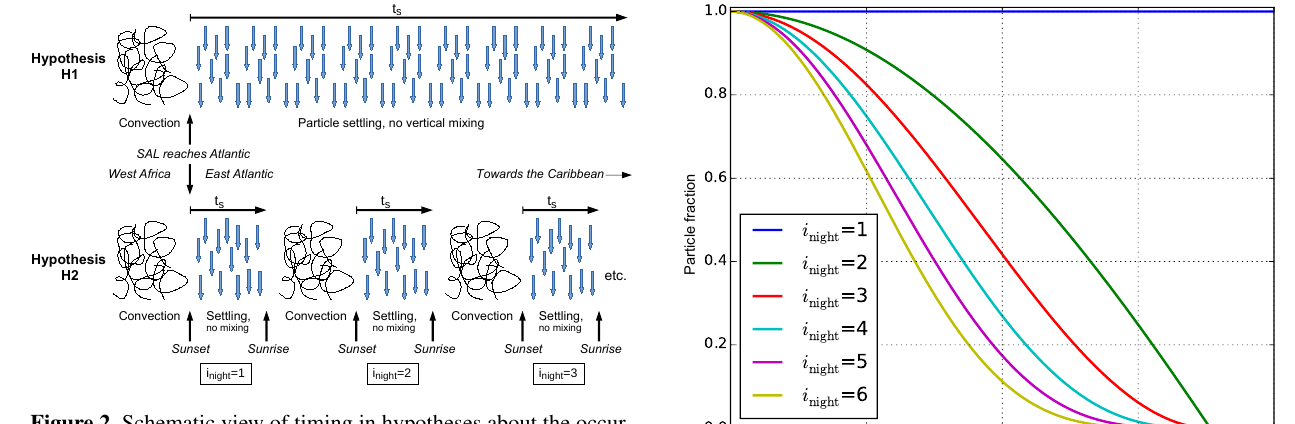
Figure 2. Schematic view of timing in hypotheses about the occur- rence of settling and convective vertical mixing within the SAL.